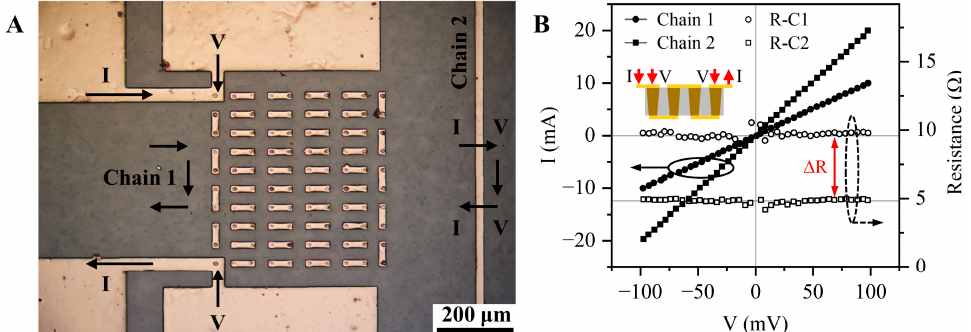
Figure 7. ( A ) Sample with a serpentine series circuit on the surface of both sides of the TDV containing 100 through vias. ( B ) Test results of the I–V curves obtained by the 4PP method and the corresponding DC resistance.